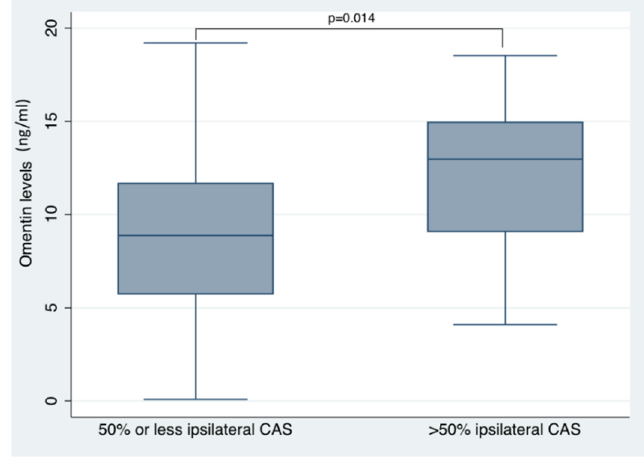
Figure 3. Significantly higher circulating omentin circulations are noted in patients with ≥ 50% ipsilateral carotid artery stenosis compared to patients without evidence of carotid artery stenosis. Within each boxplot, horizontal blue lines denote median values; lower and upper box boundaries correspond to the 25th and 75th percentiles, respectively; whiskers above and below the box denote the maximum and minim values. CAS: carotid artery stenosis.